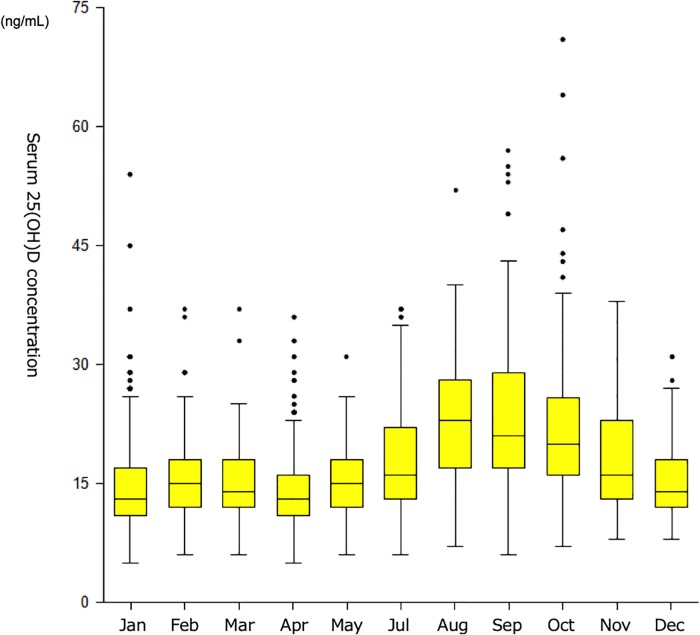
Serum 25(OH)D levels in relation to sampled months.Serum 25(OH)D was less than 20ng/mL in 1,233 of 1,745 samples (70.7%). There was a clear seasonal change with a peak at the end of summer and a trough in early spring. The median level of serum 25(OH)D in each season was 15, 14, 19, and 20 ng/mL in winter (Dec-Feb), spring (Mar-May), summer (Jul-Aug) and autumn (Sep-Nov).